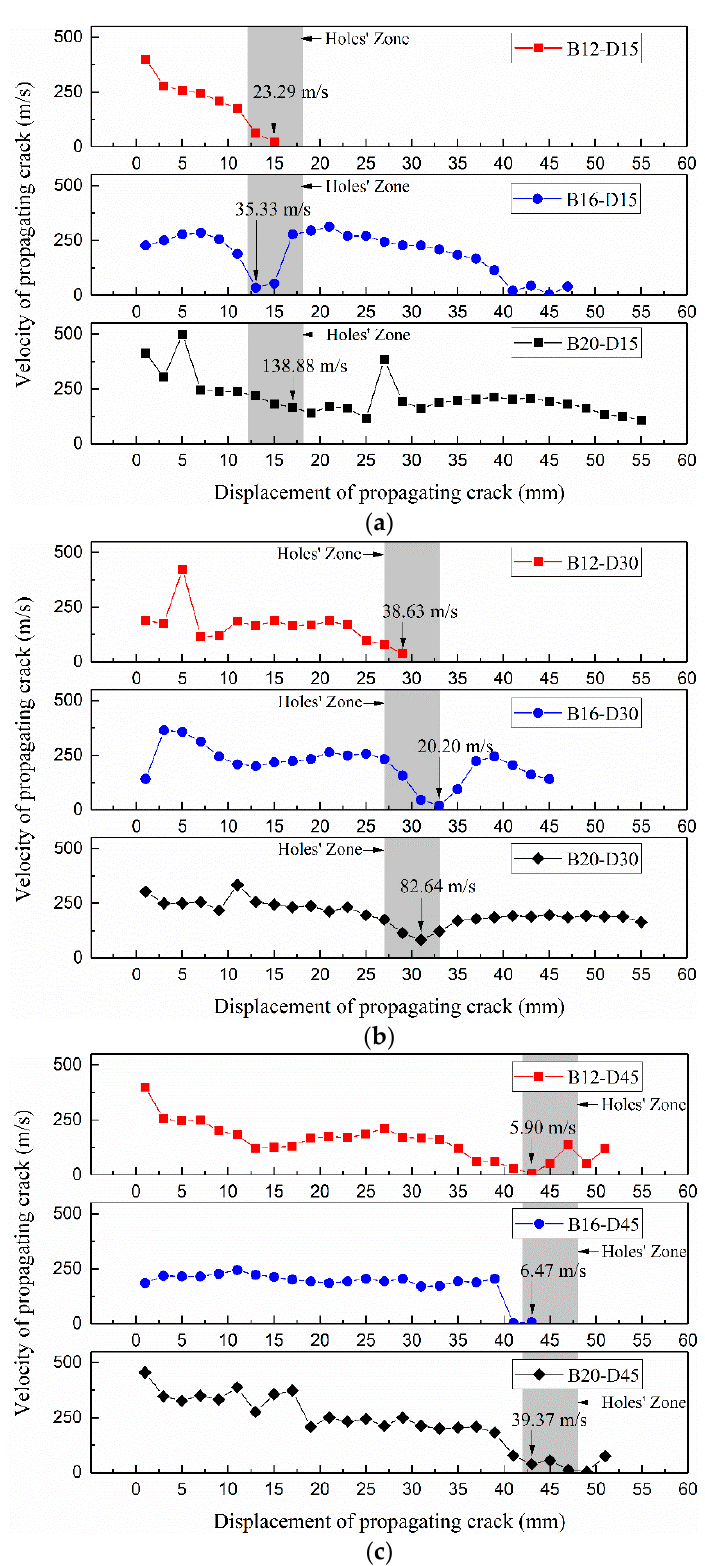
Figure 7. Crack propagation velocity curves of different types of specimen. ( a ) Specimen with constant D = 15 mm. ( b ) Specimen with constant D = 30 mm. ( c ) Specimen with constant D = 45 mm.